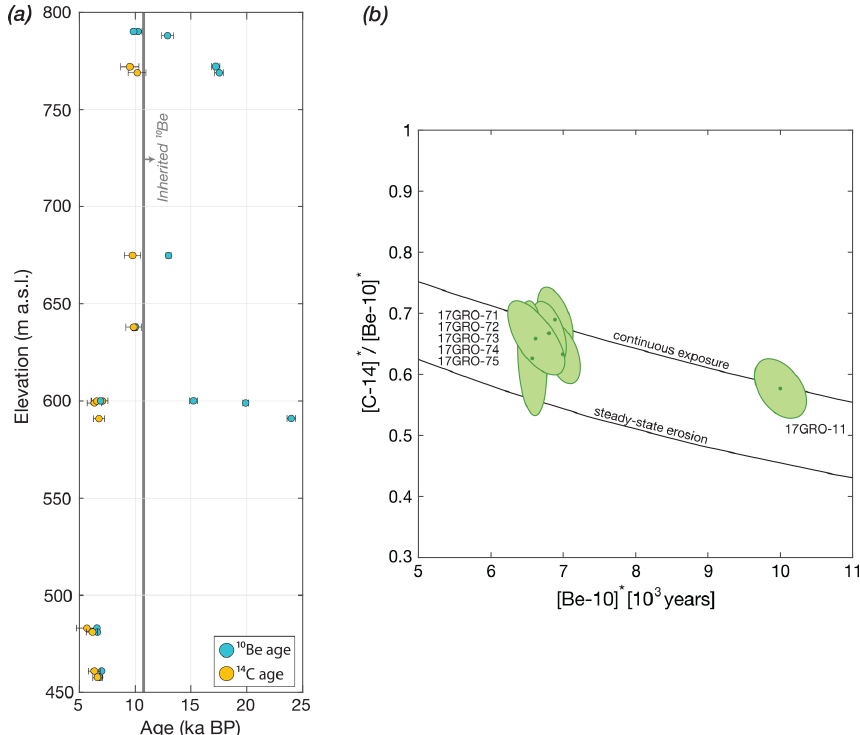
Figure 14. (a) 10 Be– 14 C apparent exposure ages from the northeastern and southwestern sides of KNS plotted against sample elevation. Apparent 10 Be ages that are older than ∼ 10 . 3ka are influenced by isotopic inheritance, yet their corresponding in situ 14 C ages are younger and consistent with Holocene-only exposure histories. In situ 14 C ages vs. sample elevation are consistent with ice-margin thinning. (b) Paired 14 C– 10 Be diagram. The x axis is the measured 10 Be concentration normalized by the site-specific production rate (years); the y axis is the measured 14 C / 10 Be ratio normalized to the production ratio. We use a regionally constrained 14 C / 10 Be spallation production ratio of 3.12 (Young et al., 2014). The simple exposure region (black lines) is defined by the continuous and steady-state erosion lines. Samples that are influenced by isotopic inheritance are excluded because they yield artificially low and meaningless ratios. Remaining samples are all consistent with constant exposure; we estimate a minimum burial detection limit of 625